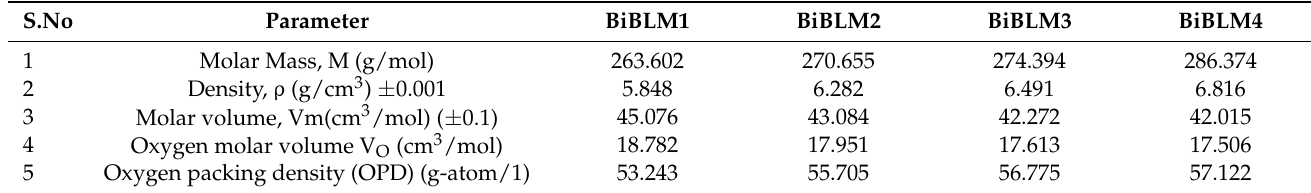
Table 1. Physical parameters of BiBLM glasses.